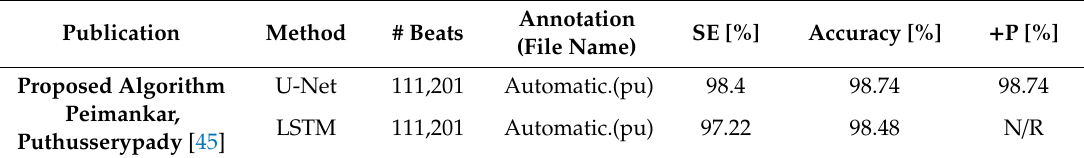
Table 4. P-wave detection performance comparison on the automatic annotated QT database [N / R: not reported].